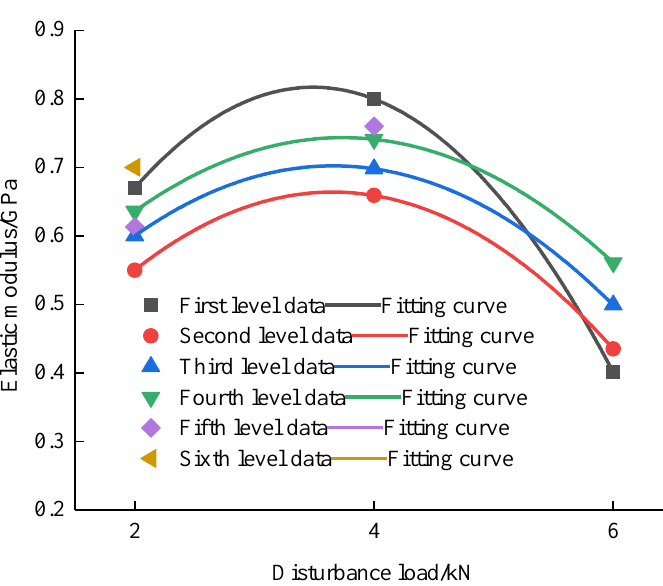
Figure 7. Variation curves of elastic modulus with disturbance load.